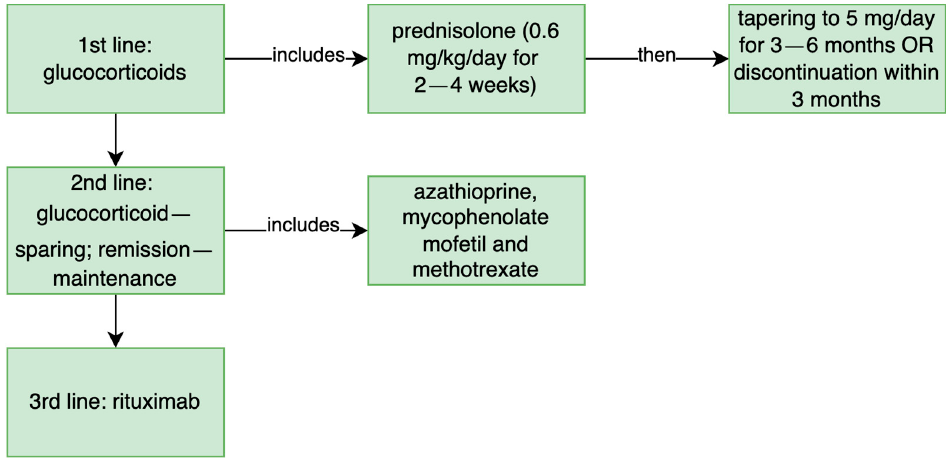
Figure 6. The treatment recommended in IgG4-related disease